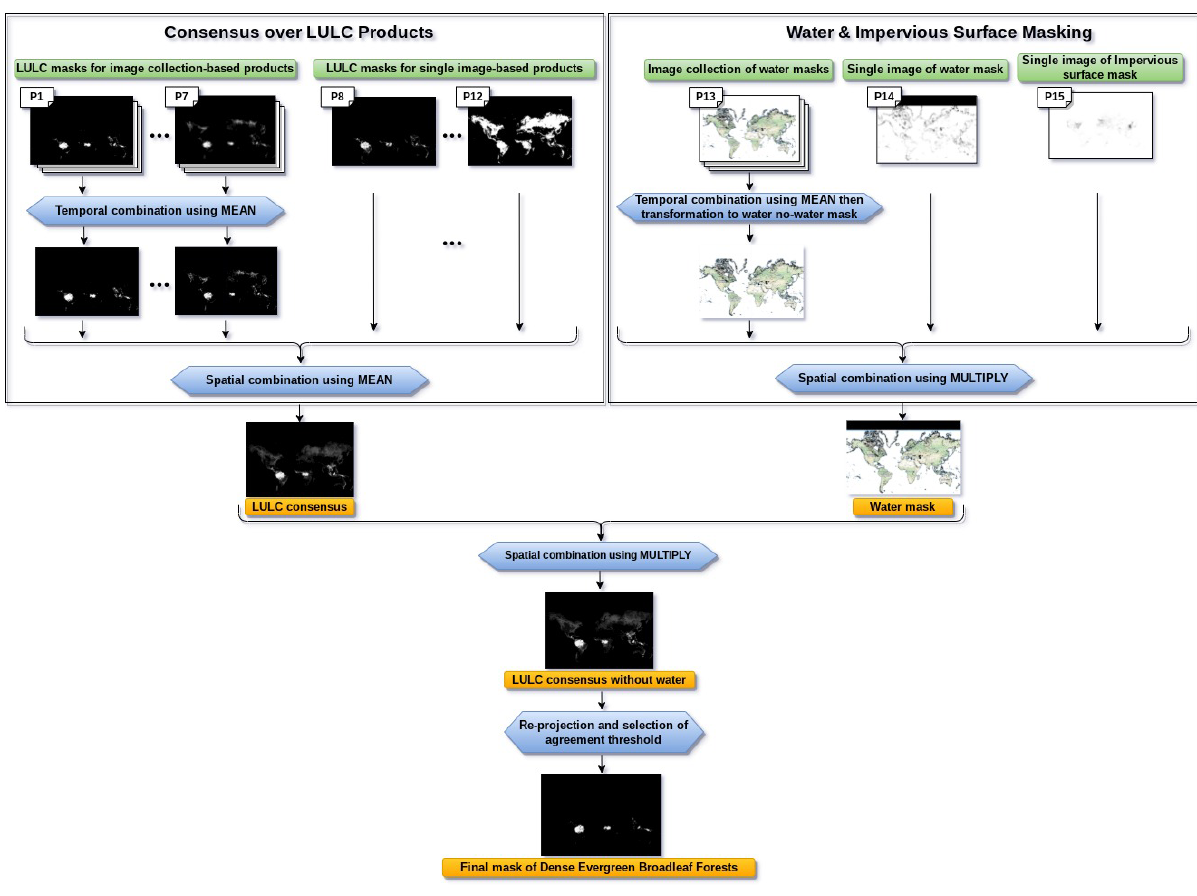
Figure 3. Example of the final mask creation process for the dense evergreen broadleaf forests LULC class produced through the spatial– temporal agreement over the 15 global LULC products available in